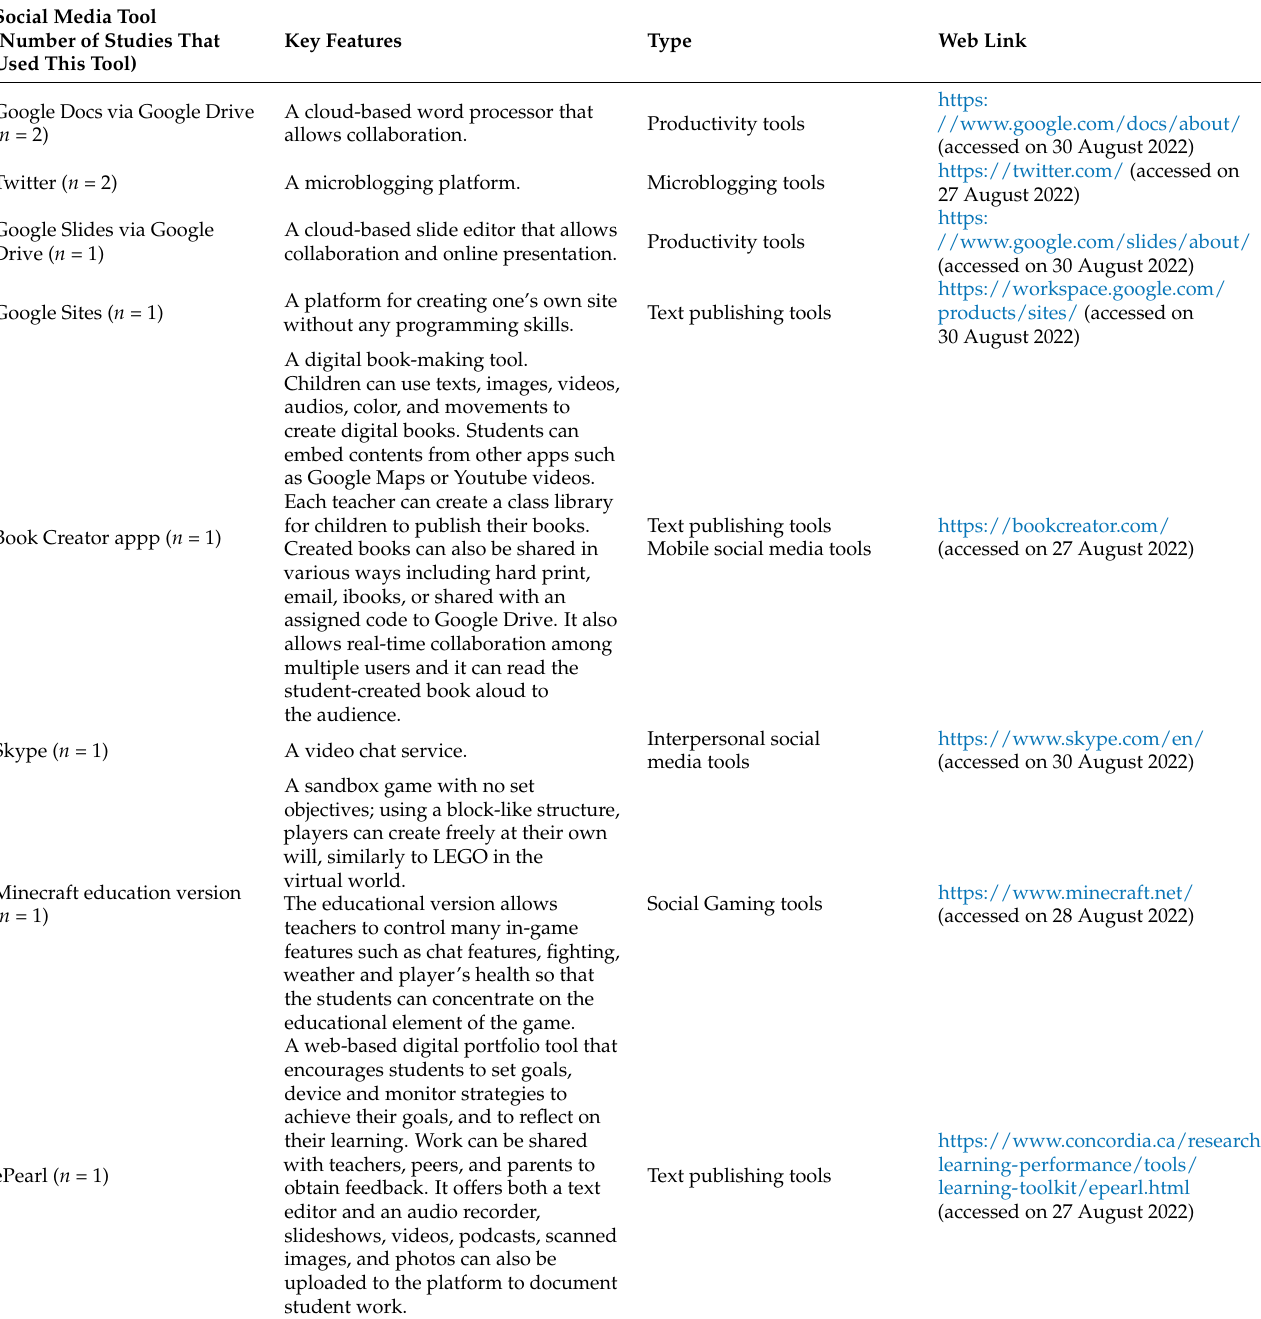
Table 3. An overview of the social media tools used in the included